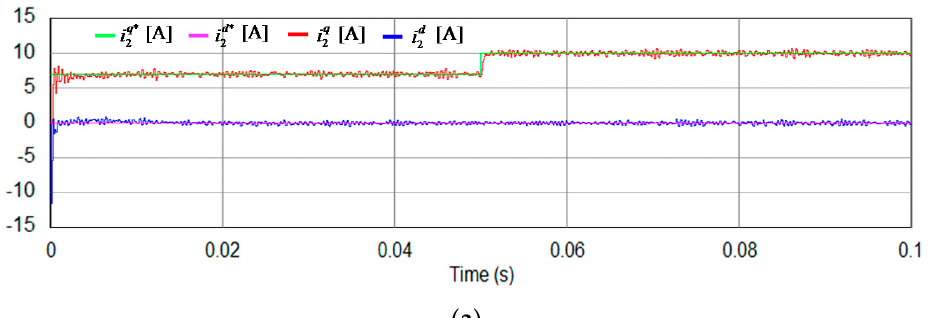
Figure 6. Simulation results for three-phase variables using the proposed discrete-time integral state feedback control scheme with state observer. ( a ) Three-phase grid-side current waveforms; ( b ) Three-phase inverter-side current waveforms; ( c ) Three-phase capacitor voltage waveforms.